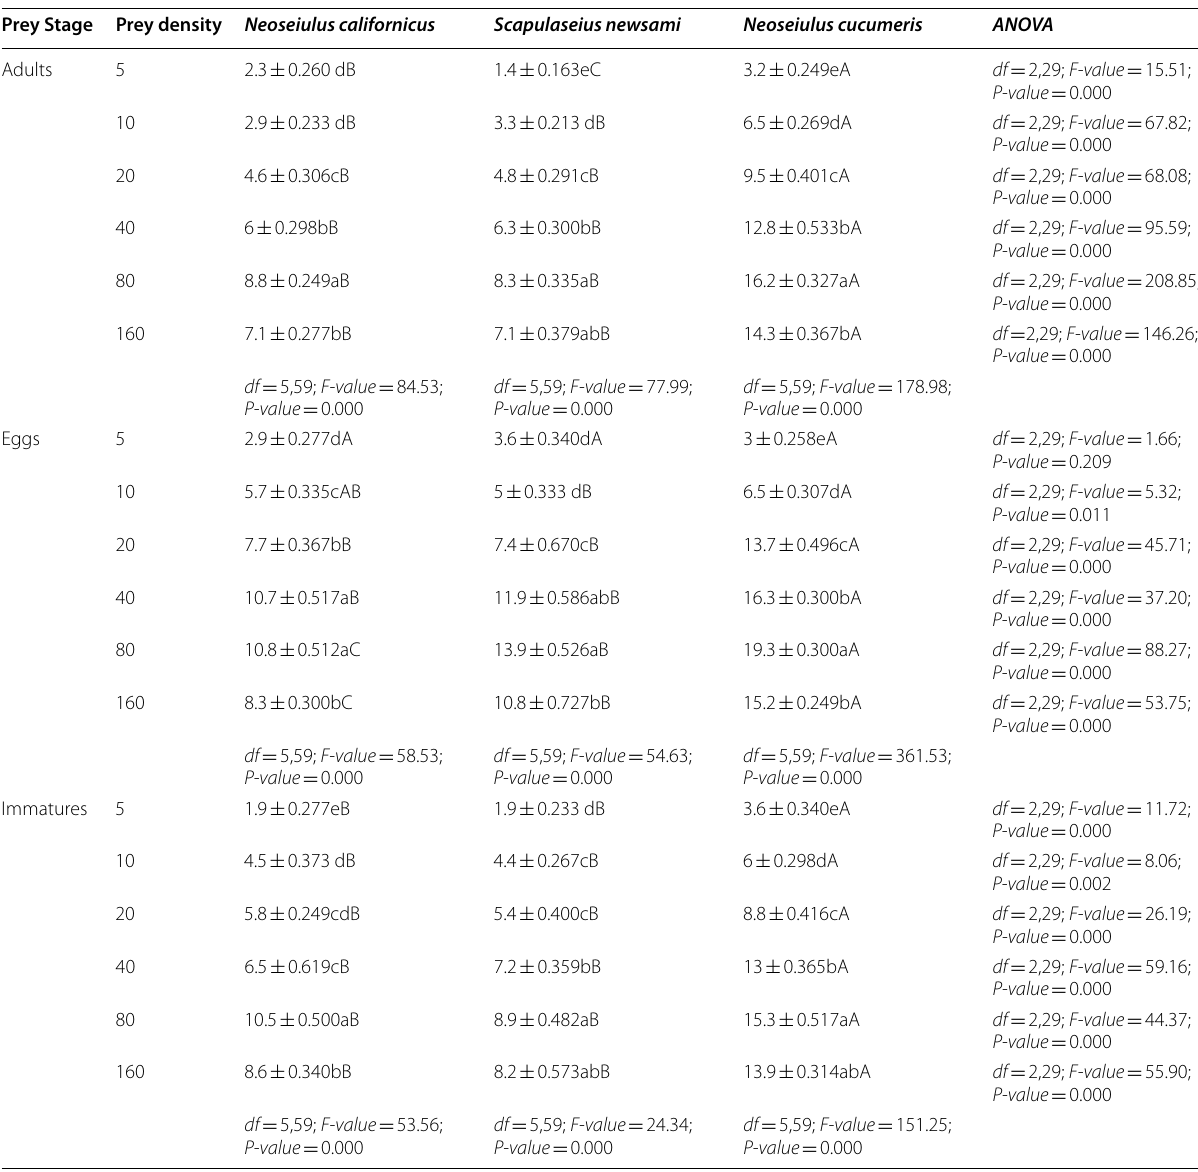
The means followed by different small letters in the table are significantly different ( P < 0.05, Tukey’s test) in the same column, the values followed by different capital letters in the table are significantly different ( P < 0.05, Tukey’s test) in the same line. The values are presented as mean